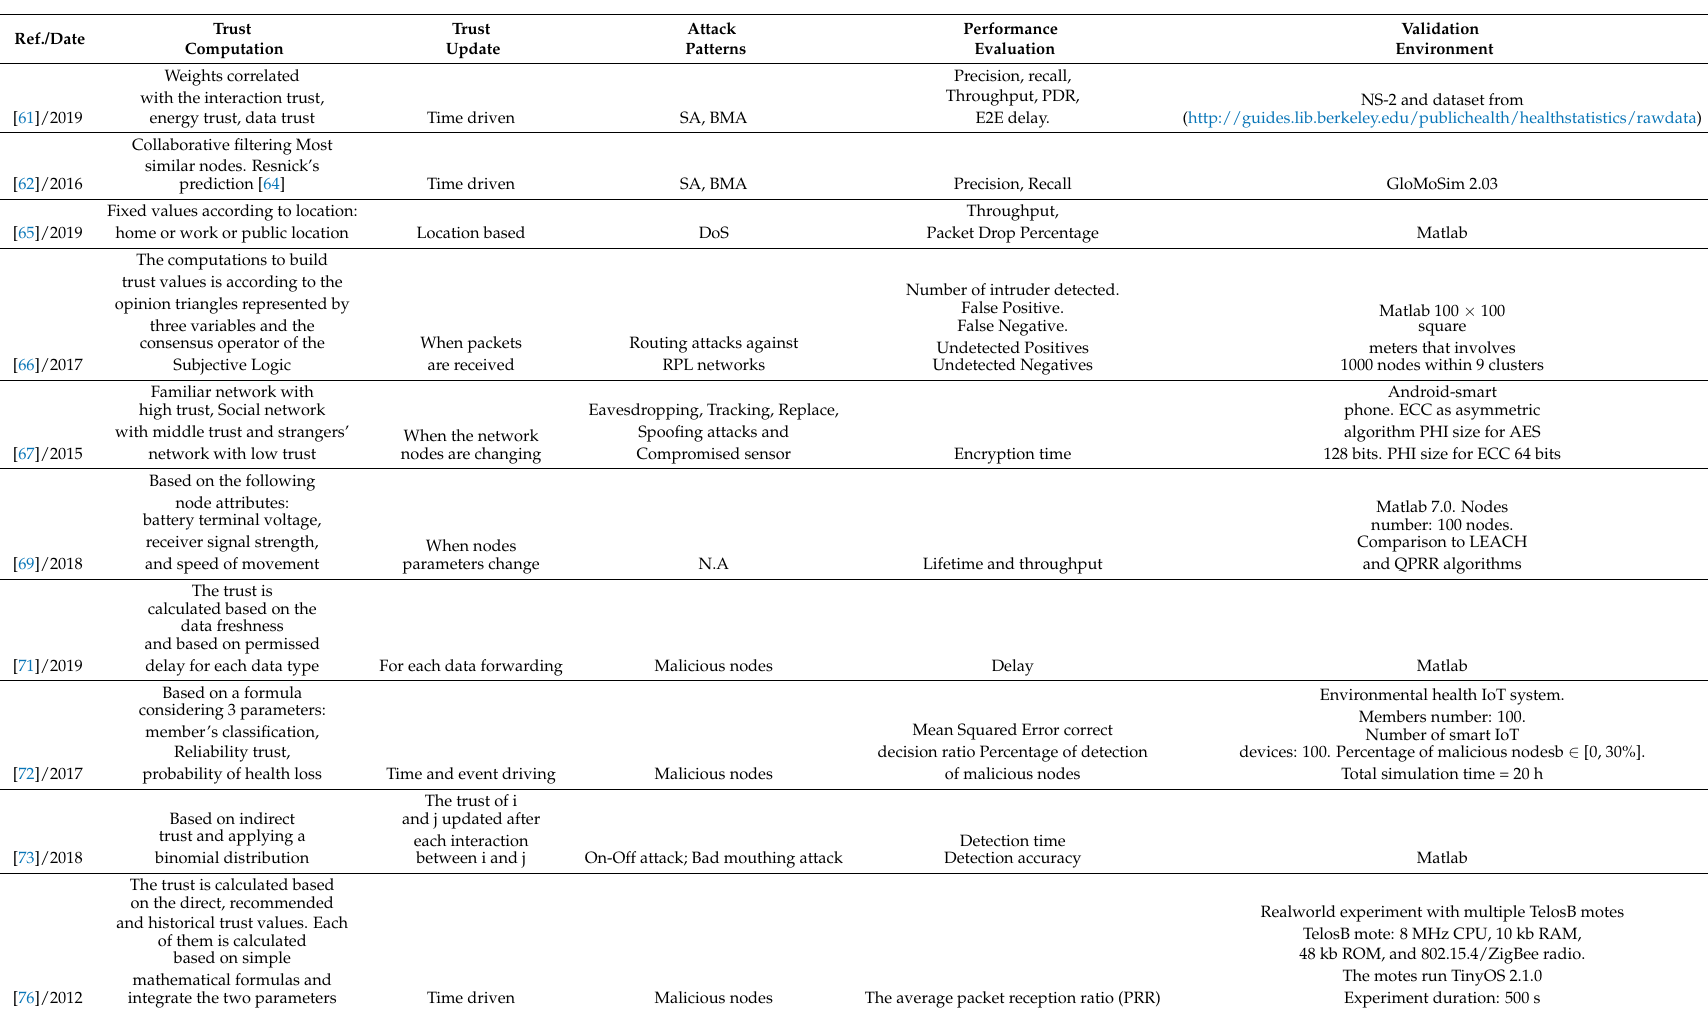
Table 4. Surveys related to the security in